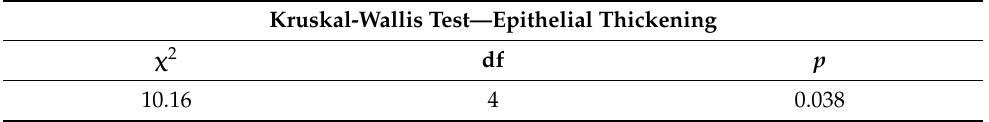
Table 9. Kruskal-Wallis test for the variable “epithelial